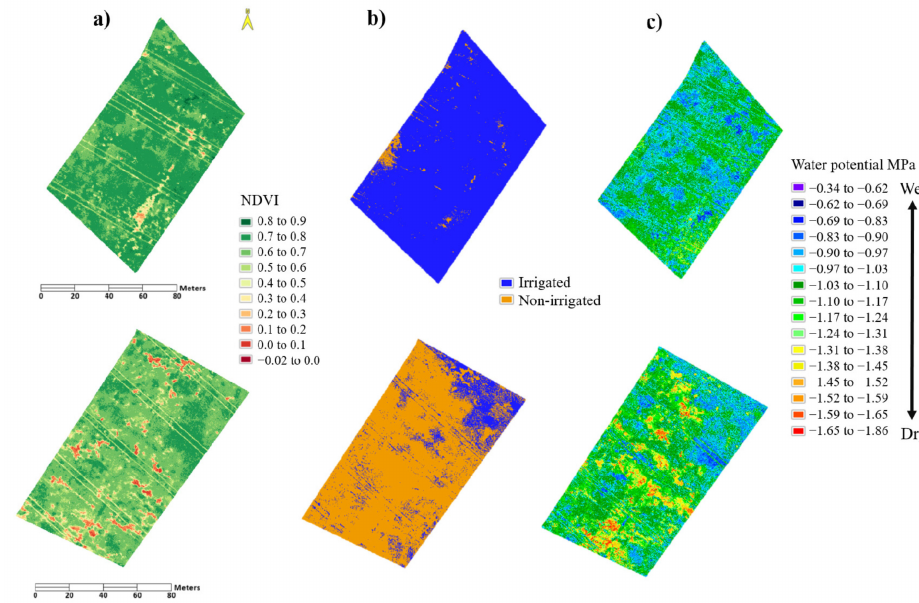
Figure 6. Processed scene images of irrigated (top images) and non-irrigated (bottom images) field sections over green fruit. ( a ) NDVI images of scenes. ( b ) Classified images of irrigated and non-irrigated scenes. ( c ) Predicted images of water